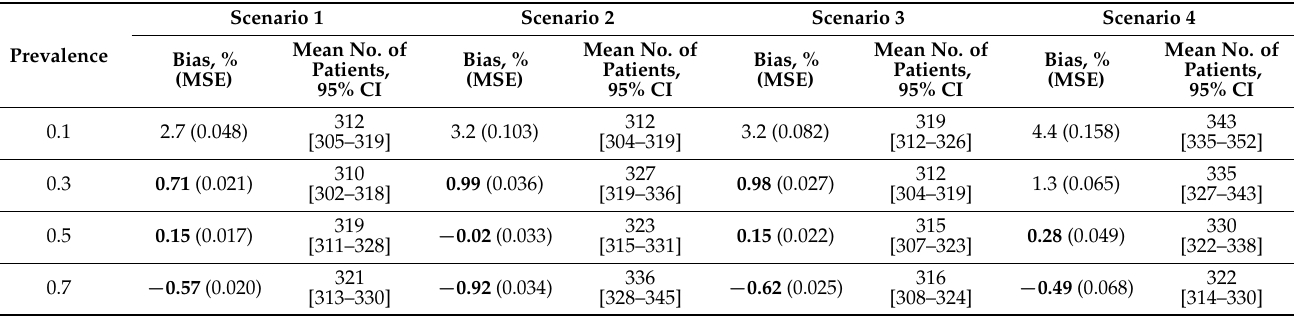
Figure 3. Line plots of chosen cut-off points for the first nine trials of scenario 1 with a prevalence of 0.5. Cut-off points were determined for n = 101, 151, 201, . . . , 1401 (dark blue lines). Horizontal, dashed lines indicate a maximum of 1% deviation from the true optimal cut-off point (target area). Vertical, dotted lines and vertical, dashed-dotted lines represent the points at which the heuristic and path-based algorithm hypothetically stops when using increments of n = 50 and n = 100 subjects, respectively, as these estimated cut-off points are within 1% of the corresponding precedent estimate. Table 4. Bias, mean squared error (MSE), and mean number of patients (95% CI) of cut-off points derived by the heuristic algorithm